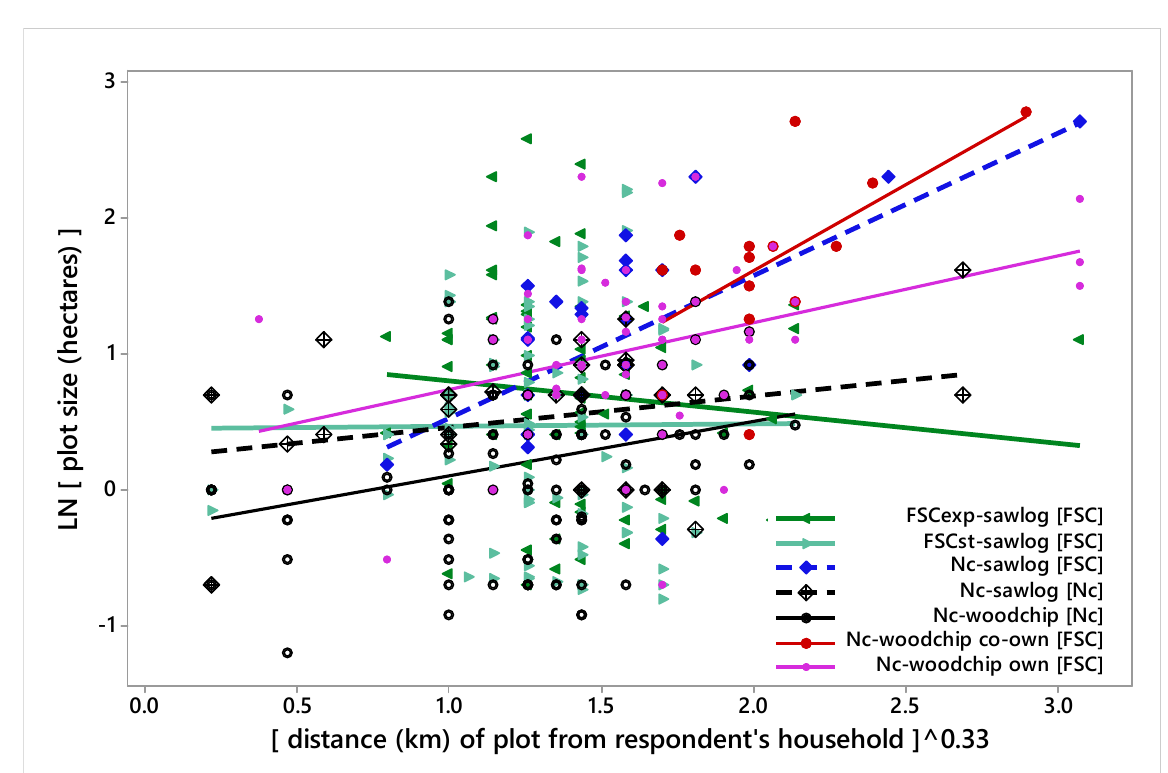
Figure 6. The size of acacia plantation plots (logarithmic scale) by plot type set in relation to the distance of the plots (0.33-power transformed scale) from the respondents’ households. The plot types include (1.) plots used for FSC-sawlog production (differentiating among plots where FSC-sawlogs had already been exploited [FSCexp], and plots where FSC-sawlog production had just started [FSCst]), (2.) plots used for Nc-sawlog production (owned by either FSC- or Nc-farmers), and (3.) plots used for woodchip production (owned by Nc-farmers, or owned or co-owned by FSC-farmers). Lines indicate a linear regression fit. All data from farmer interviews.